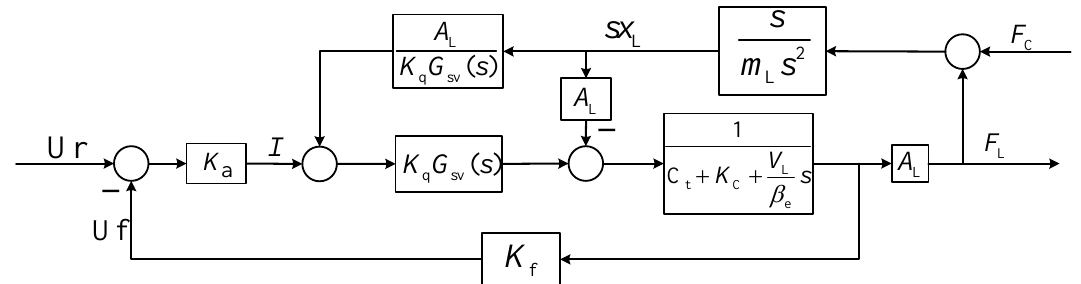
Figure 4. Pressure control block diagram of electro-hydraulic hitch with compensation link.